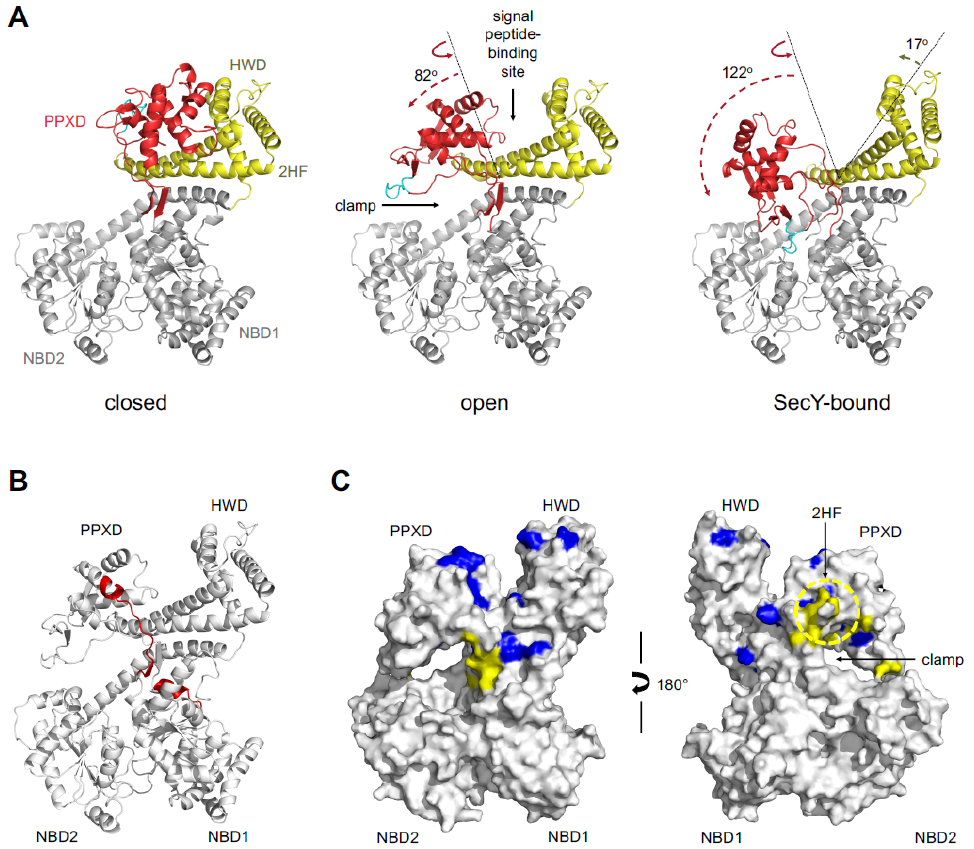
Figure 3. Conformational modeling of CDSecA2. ( A ) The closed conformation refers to our apo/ATP- γ -S-bound CDSecA2 structure, while the opened and SecY-bound conformation refer to the CDSecA2 models build using B. subtilis SecA (PDB ID 3JV2 [19]), and T. maritima SecA in complex with the SecY channel (PDB ID 3DIN [24]) as templates, respectively. The highly conserved loop of the PPXD contacting NBD1 and NBD2 in the SecY-bound CDSecA2 conformation complex is highlighted in cyan. The PPXD (red) and HWD-HSD (yellow) translations (dashed line arrows) and rotations (solid line arrows) compared to their positions in the closed structure (dotted line) are depicted. ( B ) Regions of the open CDSecA2 model lacking a template (P220-L236 and Q357-E364) for the SecY-bound CDSecA2 model are shown in red, and the remaining regions are shown as white ribbons. ( C ) The surface of the CDSecA2 model in an open conformation with surface residues previously shown to be involved in signal and nascent protein interaction in other SecA proteins is presented in two different orientations. The sequence alignment in Figure S2 was used to depict the location of these residues with the corresponding color coding. Residues implicated in the signal peptide interaction are shown in blue [6–10], and residues implicated in the nascent protein interaction are shown in yellow [19,44,45]. The clamp that encloses the protein target is depicted with an arrow, and the 2HF loop is encircled with a yellow dotted line.